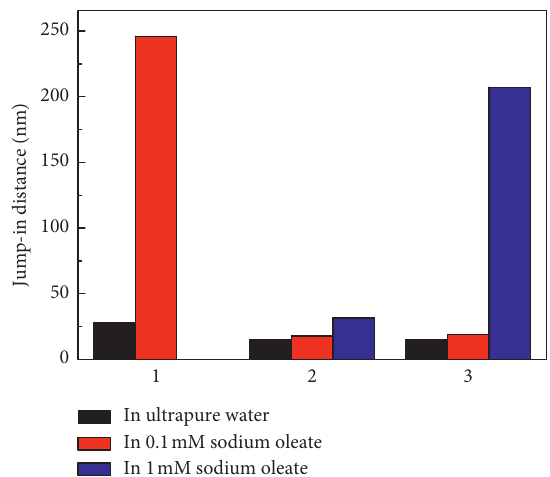
Figure 17: The jump-in distance on scheelite-scheelite, scheelite-fluorite, and scheelite-calcite in approach curves at pH